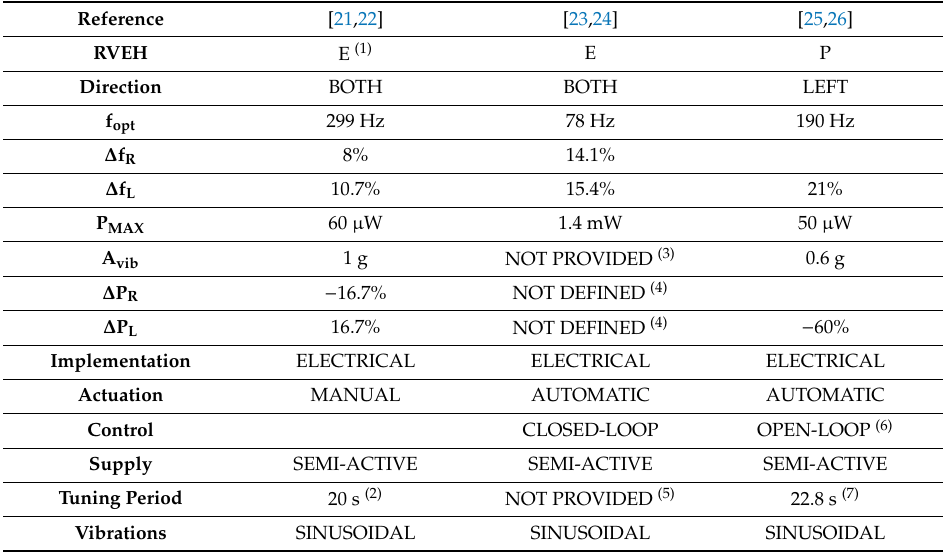
Table 3. Piezoelectric actuators based MTTs classification